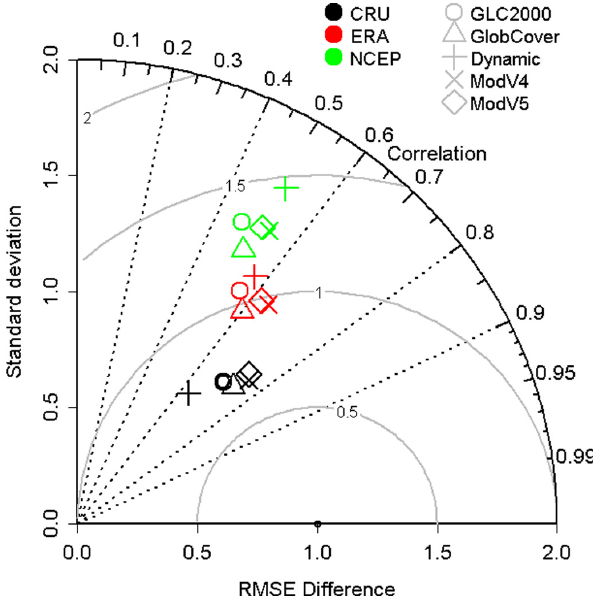
Fig. 5. Taylor diagram assessing model skill in comparison to the inferred terrestrial carbon sink. The black circle located at RMSE=1.0 and Standard Deviation=0 indicates the